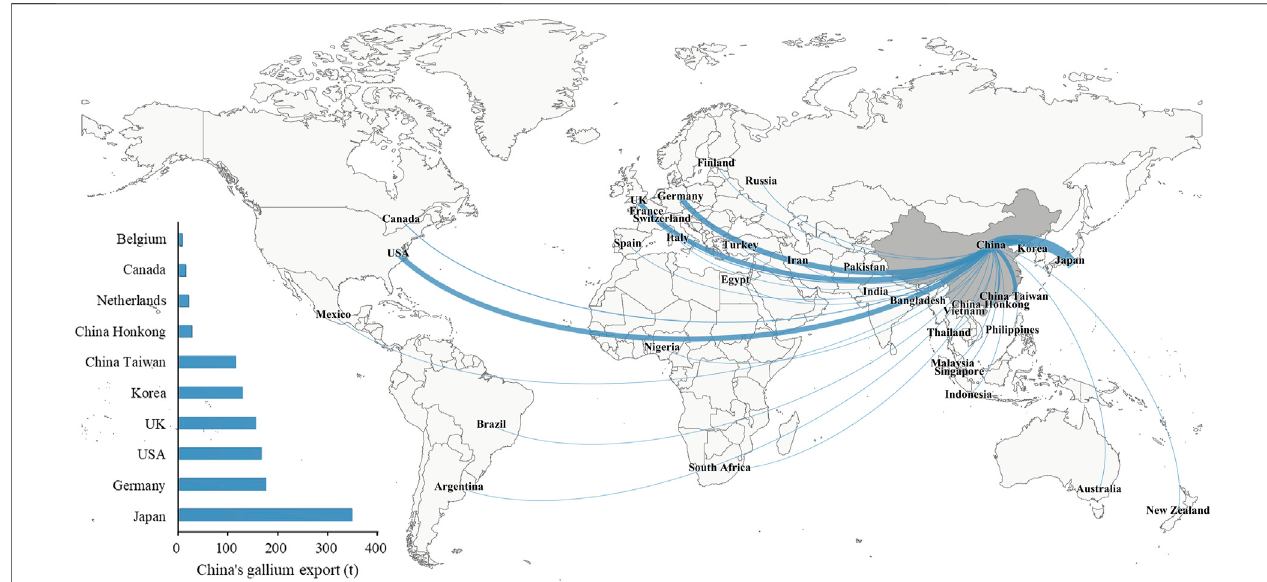
FIGURE 6 | China ’ s accumulated export gallium fl ows to its key trading partners from 2005 to 2020 (Each fl ow is proportionate to the volume of gallium exported, and the trade fl ows under 1 t are not depicted in the graph. Horizontal bars indicate the top ten biggest importers of China ’ s gallium products).